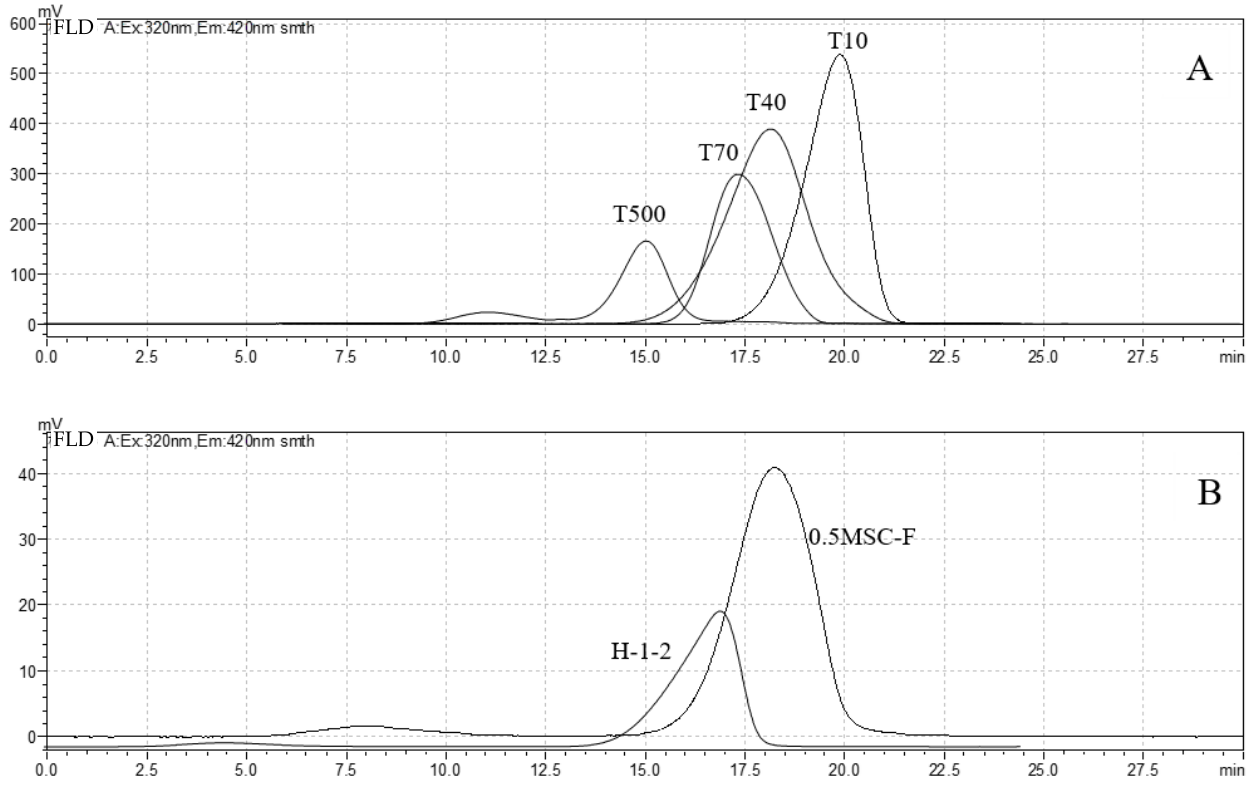
Figure 4. Gel exclusion chromatogram of 4 dextran standards and 2 polysaccharide samples with 2-AB fluorescence labeling. Dextran derivatives with 2-AB ( A ) and PHP H-1-2 -2AB and PHP 0.5MSC-F -2-AB ( B ) are shown. Table 1. RT and average molecular weight of dextran standards and polysaccharide samples with 2-AB fluorescence labeling.